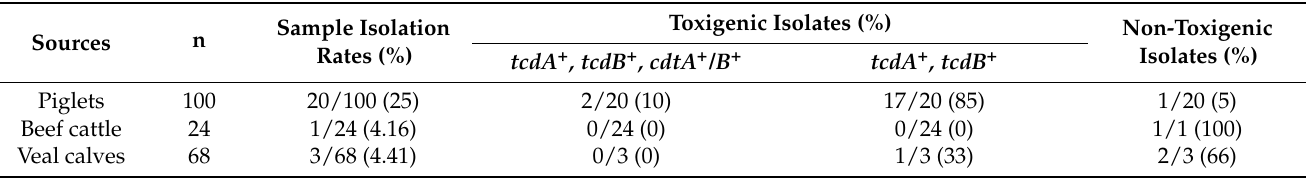
Table 1. Recovery of Clostridioides difficile